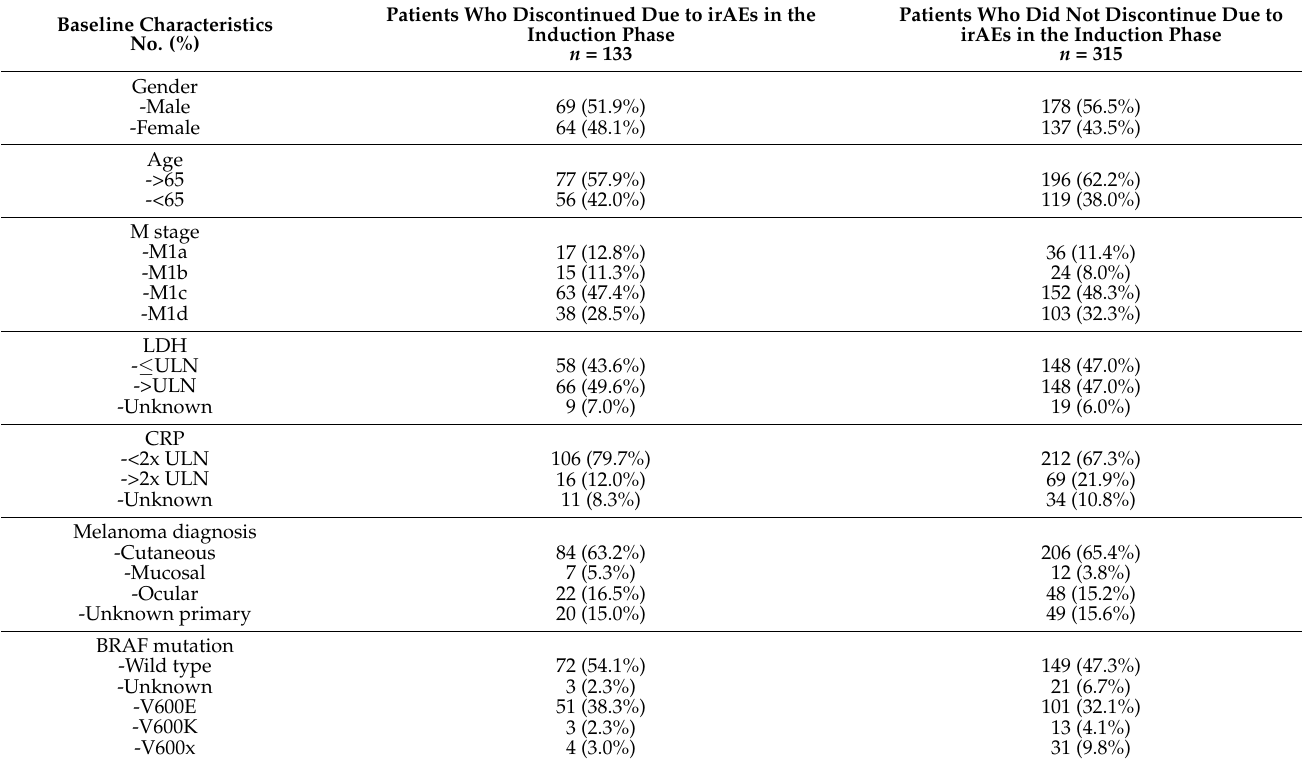
Table 1. Baseline characteristics for the patients in the cohort.